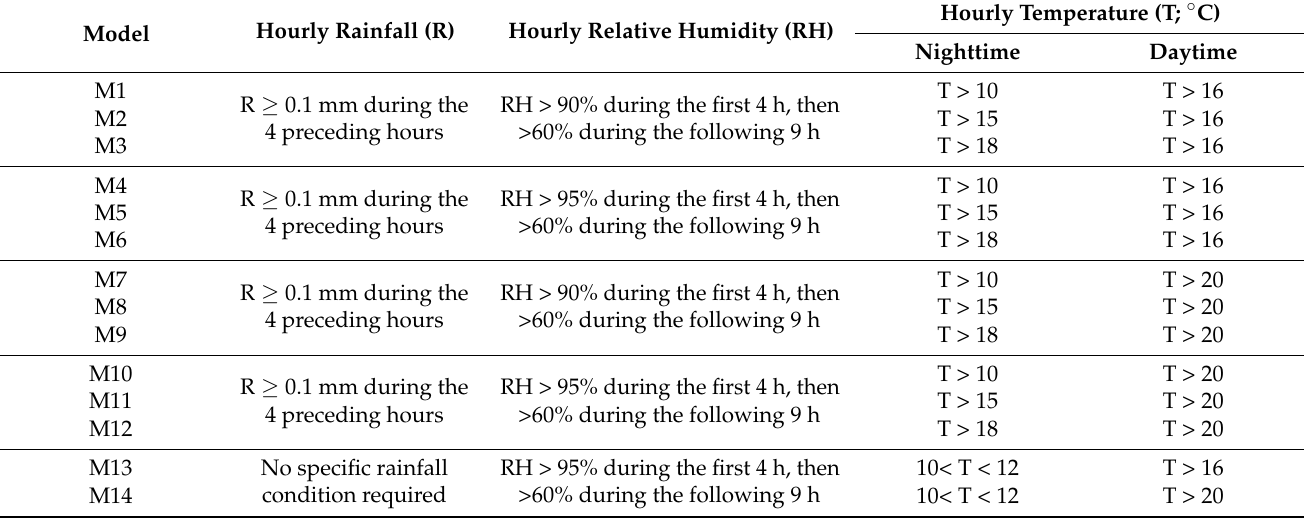
Table 4. List of the models evaluated during the testing step. Each model was defined as a combination of defined thresholds of hourly air temperature, and rainfall and relative humidity over uninterrupted hours.